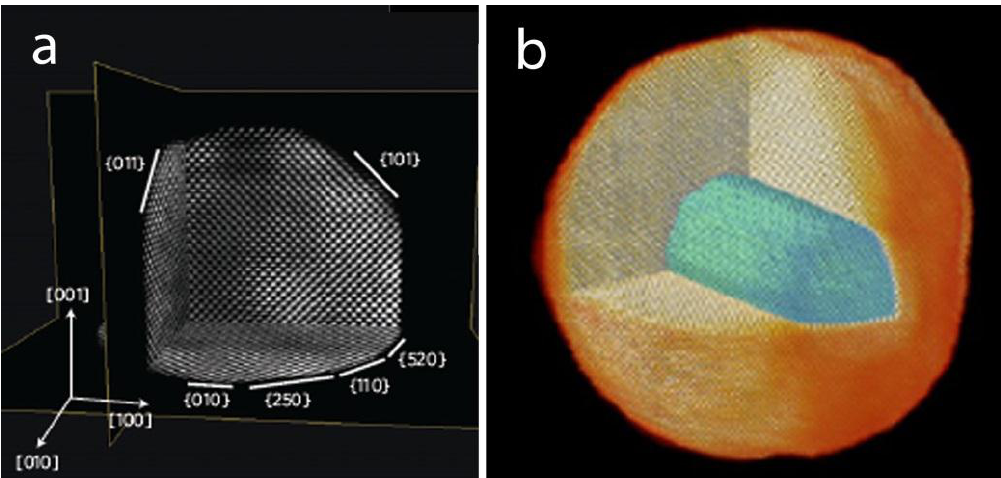
Figure 5. ( a ) Slices through the atomic resolution 3D reconstruction of a Au nanorod, revealing the atomic lattice and the surface facets present; ( b ) 3D visualization of a core—shell Au@Ag nanorod, where the Au core is rendered green, and the Ag atoms are visualized in orange [2,74].